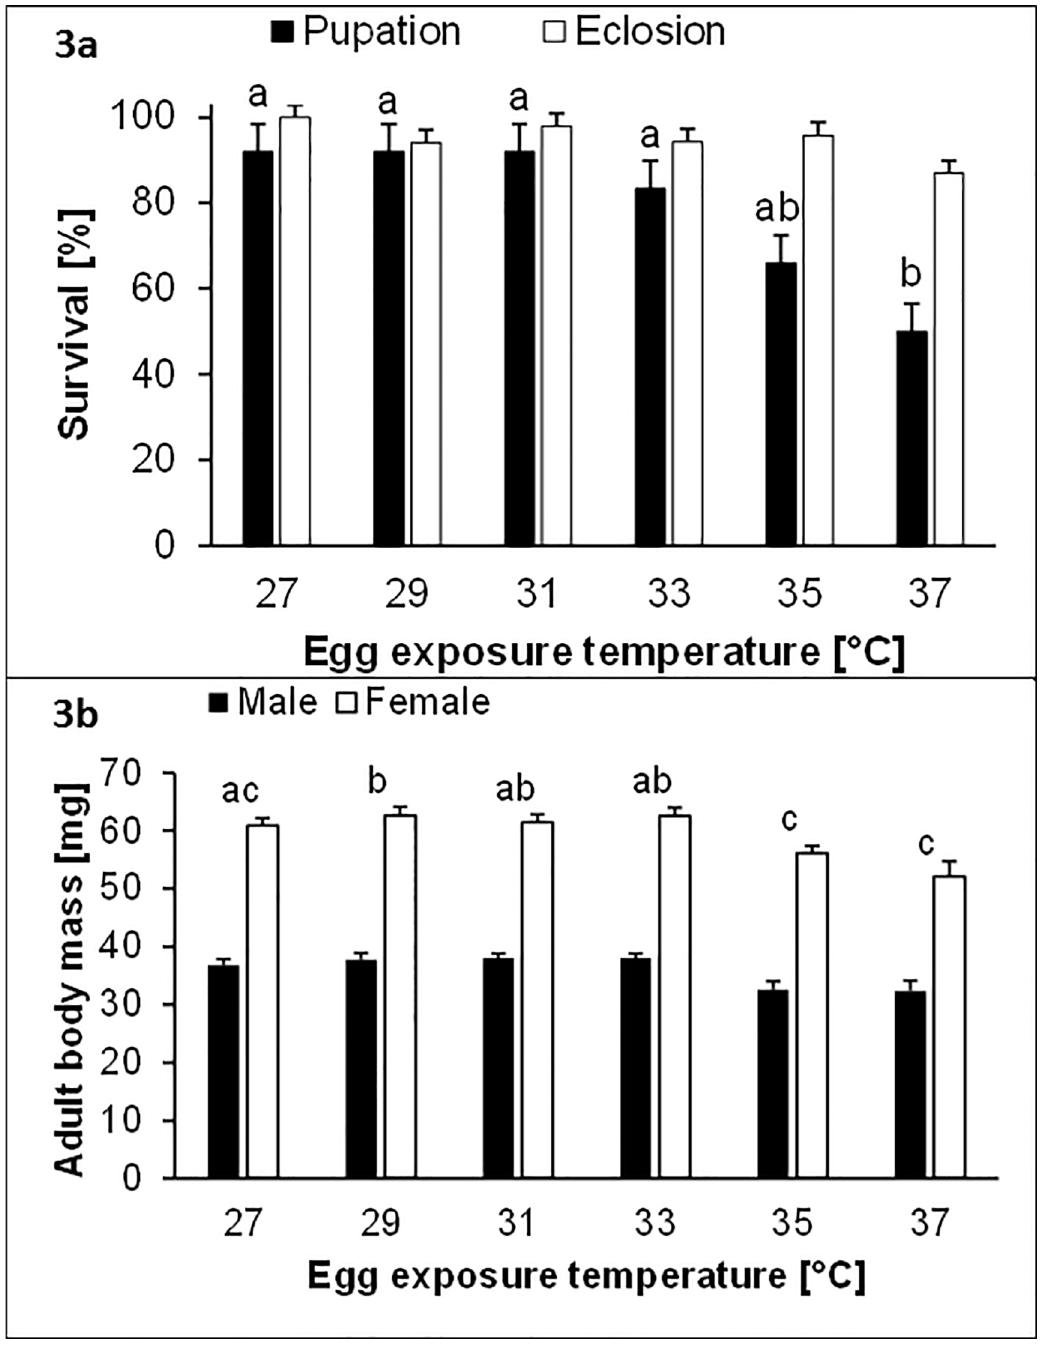
Fig 3. Survival rates until pupationand adult eclosion(a) and male and female adult body mass (b) in relationto egg temperature (24 h at 27, 29, 31, 33, 35 or 37˚C) in Bicyclus anynana . Given are means ± 1 SE. Samplesize were 5 cages with 30 individualseach (a) and 29 to 73 individualseach (b). Different lower case letters abovebars indicate significantdifferences amongtemperatures(Tukey’s HSD for equal sample